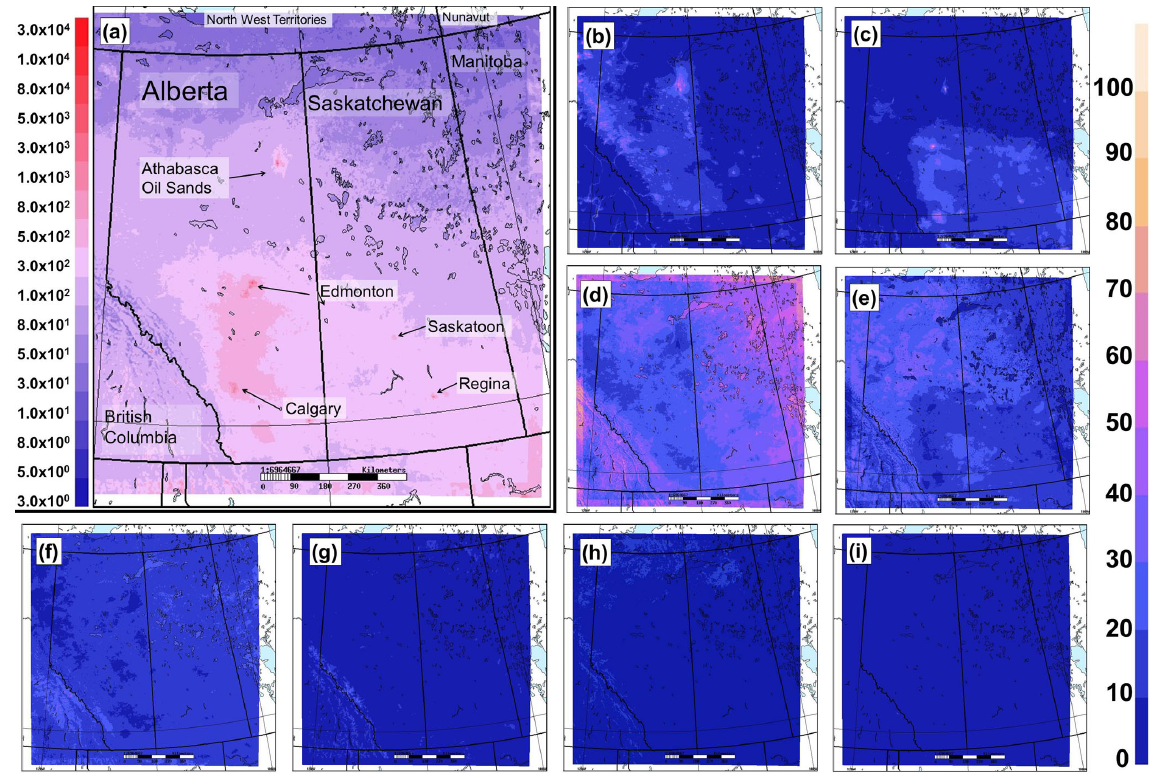
Figure 7. GEM-MACH predictions of total nitrogen deposition and its speciation. (a) Total nitrogen deposition (eqha − 1 yr − 1 ), percentages of total nitrogen deposition due to: (b) NO 2 (dry), (c) NH 3 (dry), (d) NH + ammonium (dry), (h) peroxyactylnitrate (dry). (i) each of particulate nitrate (dry), gaseous organic nitrate (dry), NO (dry) and HONO (dry) (each contribute less than 10% to N dep ).